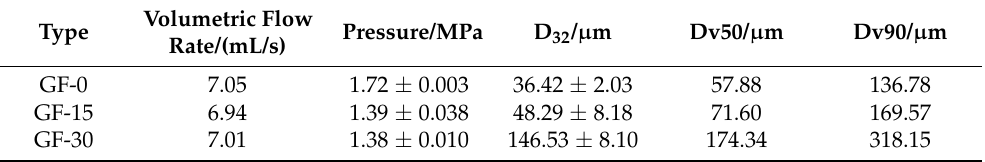
Table 3. The injection pressure and mean droplet diameters of the swirl nozzle for different gelled fuels.